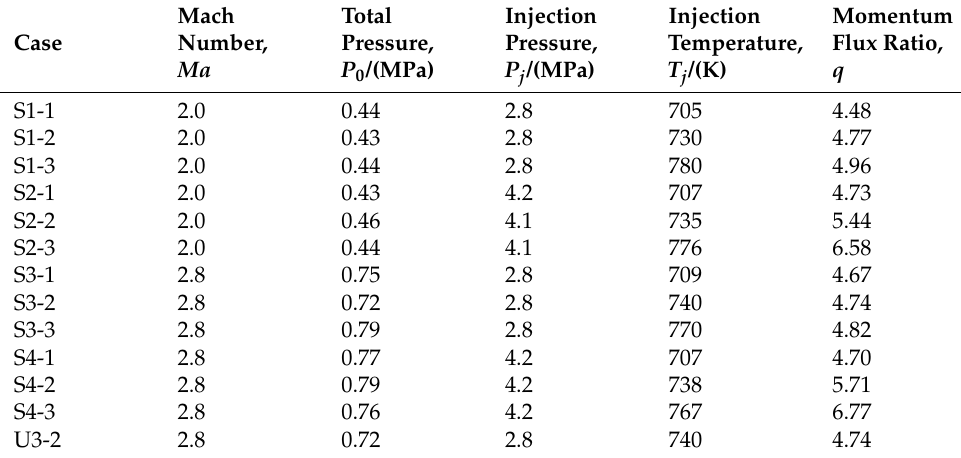
Table 2. Numerical simulation